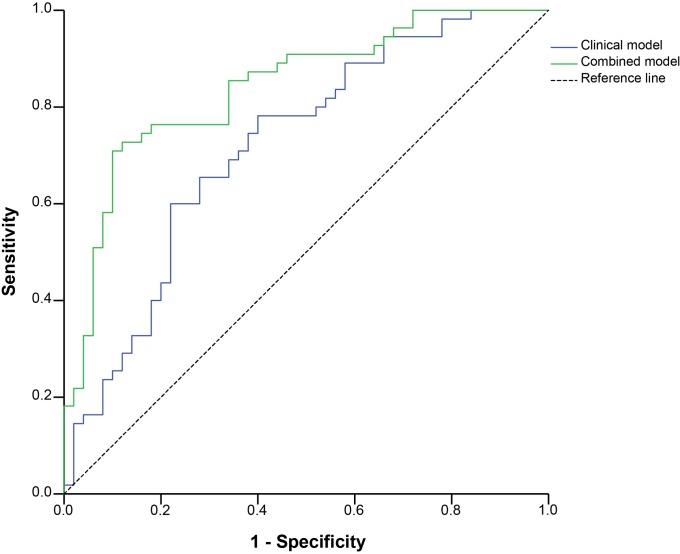
Receiver operating characteristic curves of clinical and combined model between good- and non-responder to TNFi.The clinical model containing the 16 selected baseline clinical parameters; the combined model included four metabolites with p < 0.05 in multivariable logistic regression with backward selection in addition to the clinical model.